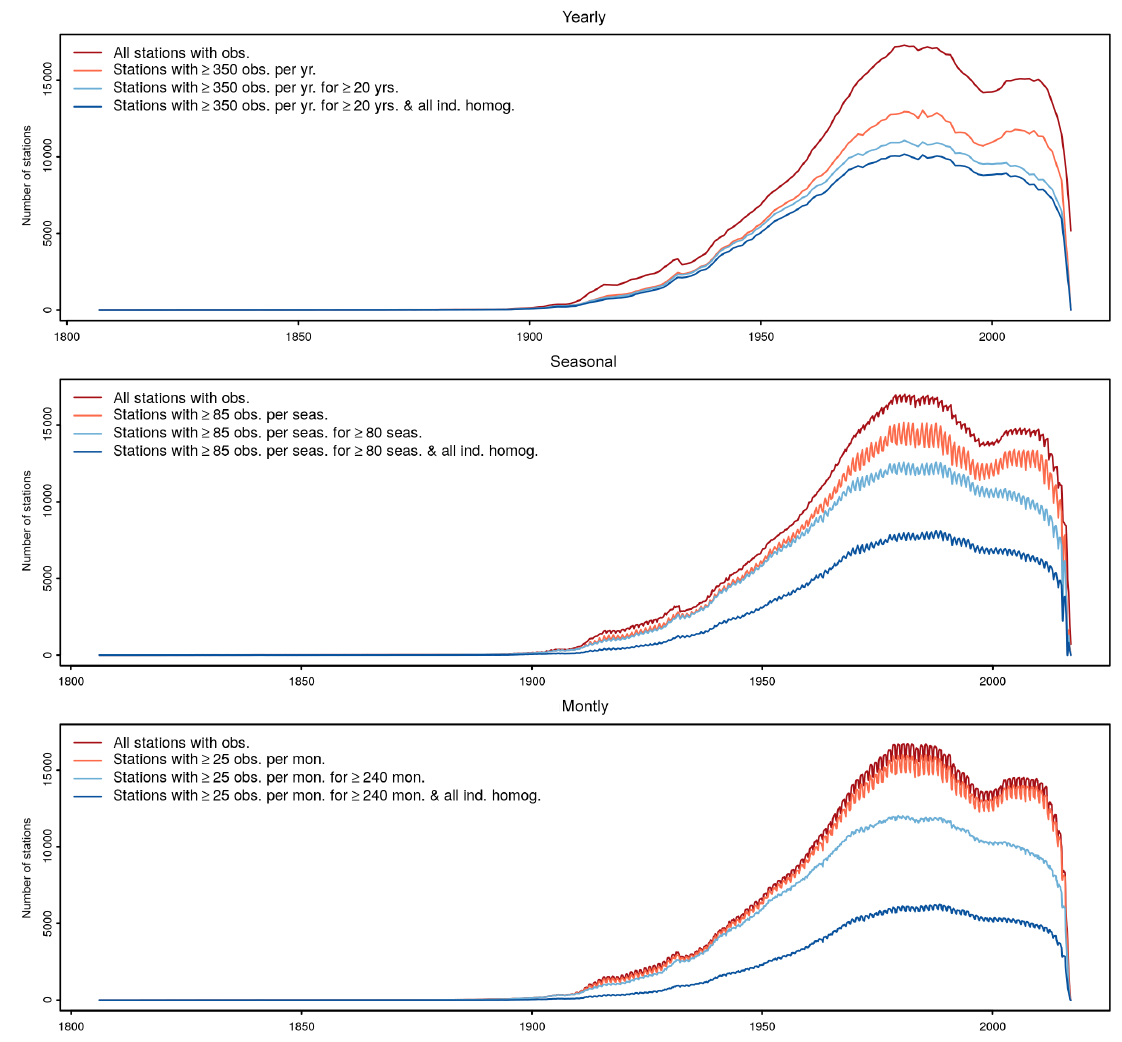
Figure 8. Temporal evolution of global station coverage, conditional on different data-selection criteria for yearly, monthly and seasonal timescales. Successively, the following criteria are applied: (i) all stations that at least one observation for the respective time step (i.e. year, season, month). (ii) Stations that have at least a critical number of observations for each time step (critical values depend on the timescale; see Sect. 3.1.3). (iii) Stations that have at least a critical number of observations for the equivalent of 20 station years (i.e. 20 yearly values, 20 × 4 = 80 seasonal values, 20 × 12 = 240 monthly values). (iv) Stations where criterion (iii) applied and all indices were considered to be useful in the homogeneity analysis (see Sect.